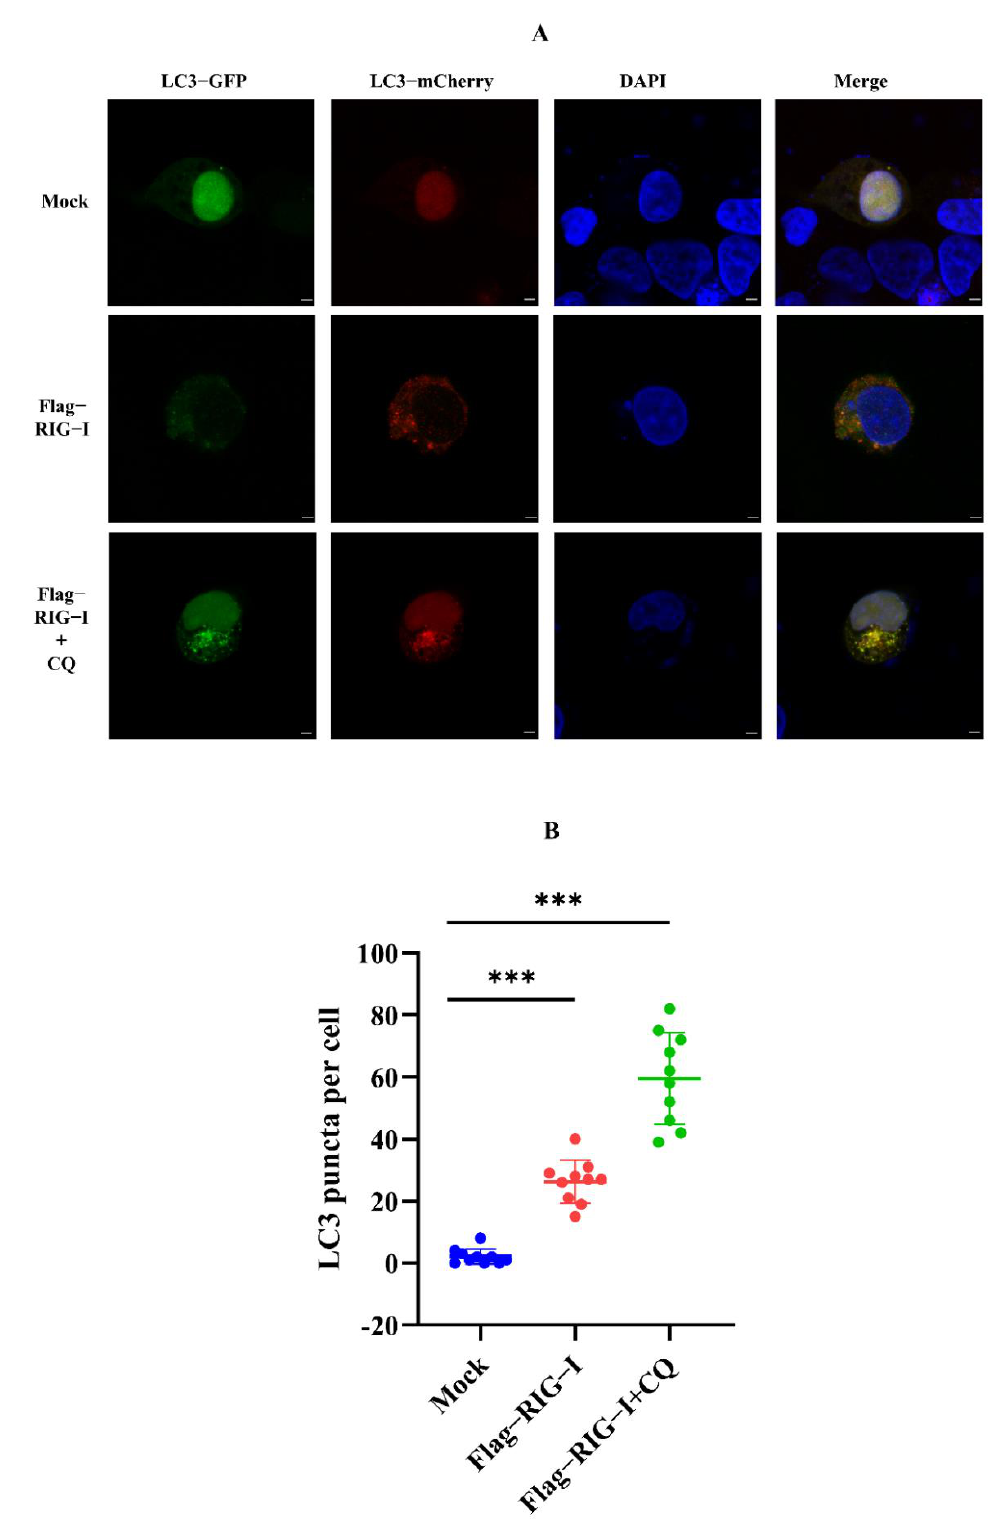
Figure 3. Observation of LC3 with overexpression of RIG-I in HEK 293T cells. ( A ) Fluorescence analysis for confocal observation of HEK293T cells transfected with Flag-RIG-I plasmid. Scale bar, 3 μm. ( B ) Numbers were counting of LC3-GFP-mCherry puncta formation in HEK 293T cells transfected with or without the Flag-RIG-I plasmid. (Data from 10 cells were shown, and bars represent the mean ± standard deviation, *** p < 0.001.)